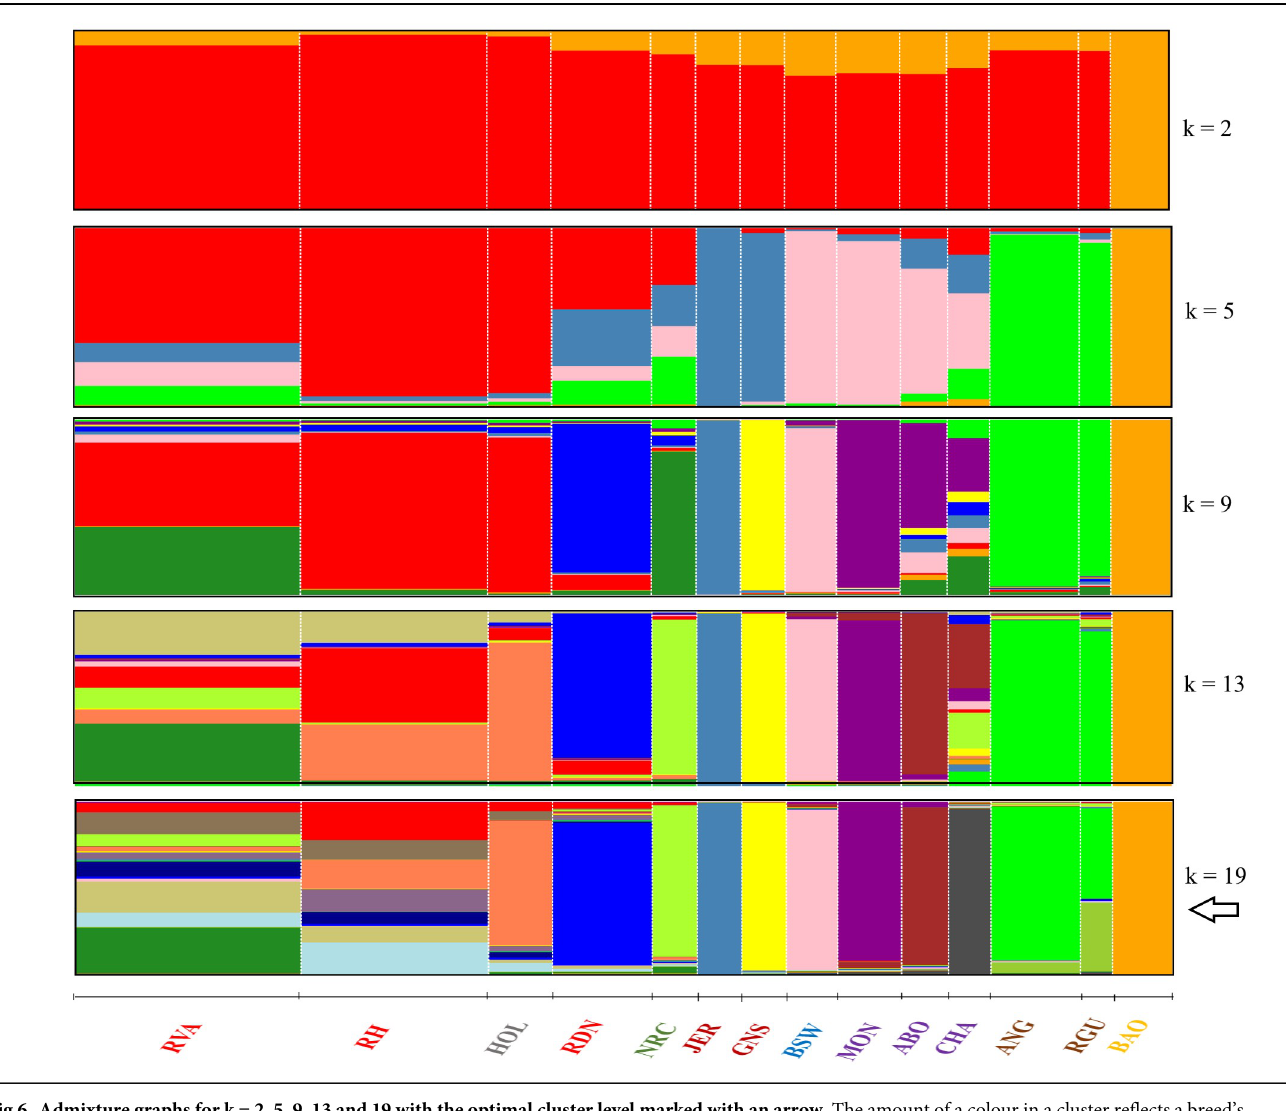
Fig 6. Admixture graphs for k = 2, 5, 9, 13 and 19 with the optimal cluster level marked with an arrow. The amount of a colour in a cluster reflects a breed’s proportion of genetic variation originating from that colour. Breed names are coloured according to geographical origin: Germany (red), Northern Europe (grey), Norway (green), Channel Islands (dark red), Switzerland (blue), France (purple), Scotland (brown) and Burkina Faso